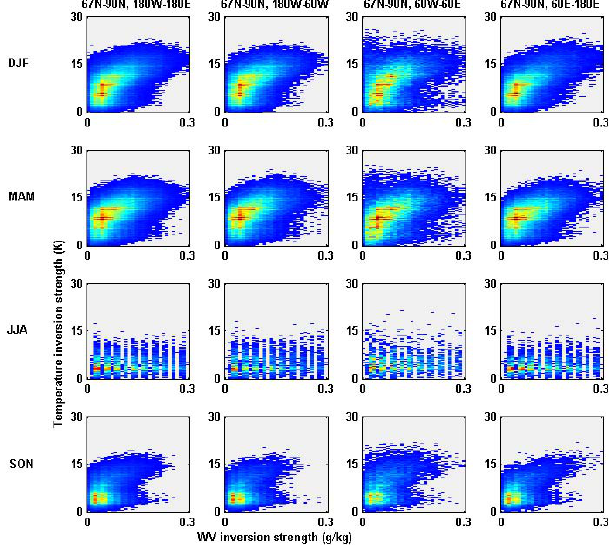
Fig. 7. The joint histograms of temperature and WV inversion strengths for different seasons and for the entire Arctic (left-most column) and for three distinct regions (180 ◦ W–60 ◦ W, 60 ◦ W– 60 ◦ E, and 60 ◦ E–180 ◦ E).